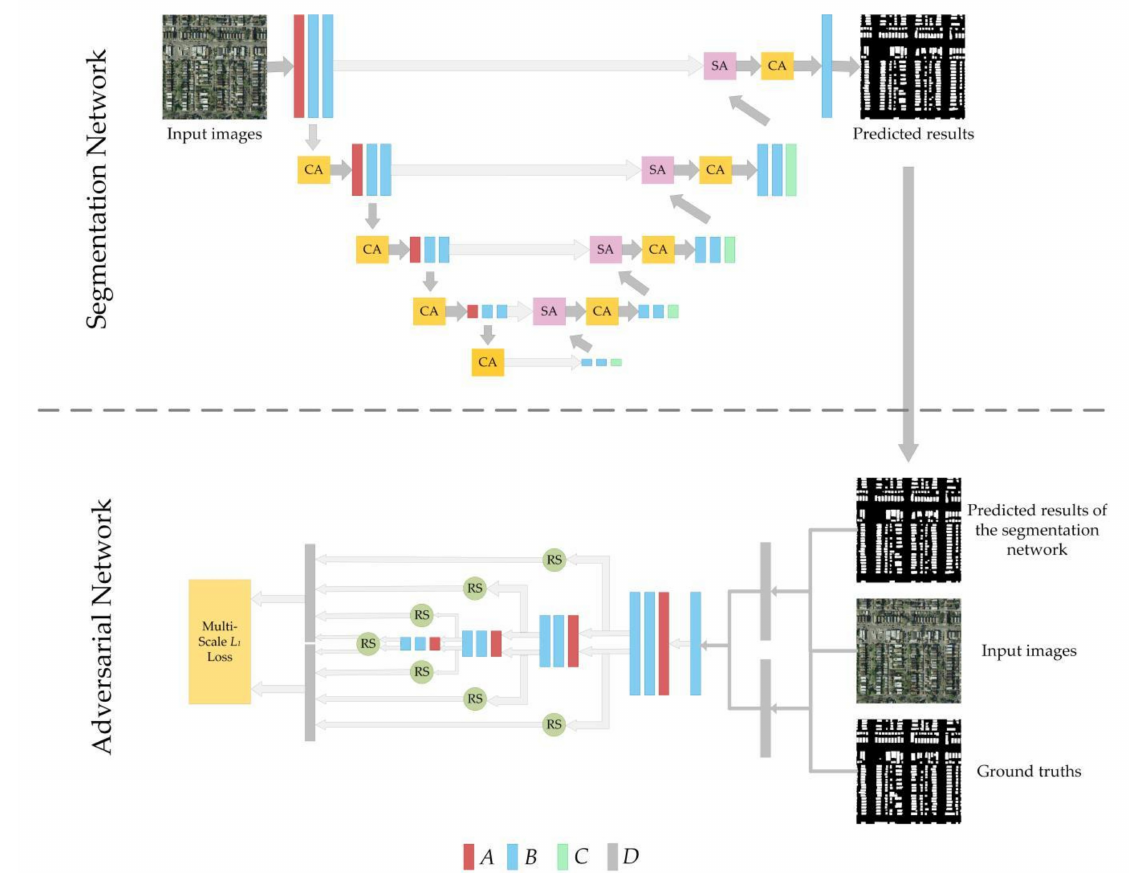
Figure 1. Architecture of the proposed generative adversarial network with spatial and channel attention mechanisms (GAN-SCA). A is max pooling layer; B are convolutional + batch normalization + rectified linear unit (ReLU) layers; C is upsampling layer; D is the concatenation operation; SA is the spatial attention mechanism; CA is the channel attention mechanism; RS is the reshape